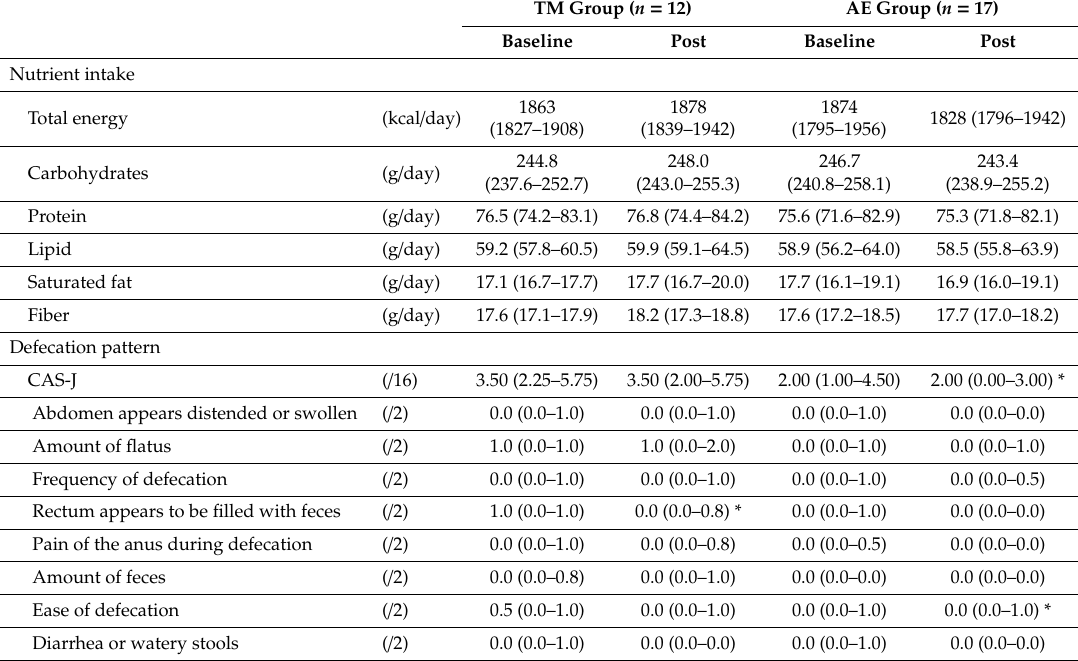
Table 3. Changes in nutrient intake and defecation pattern following the